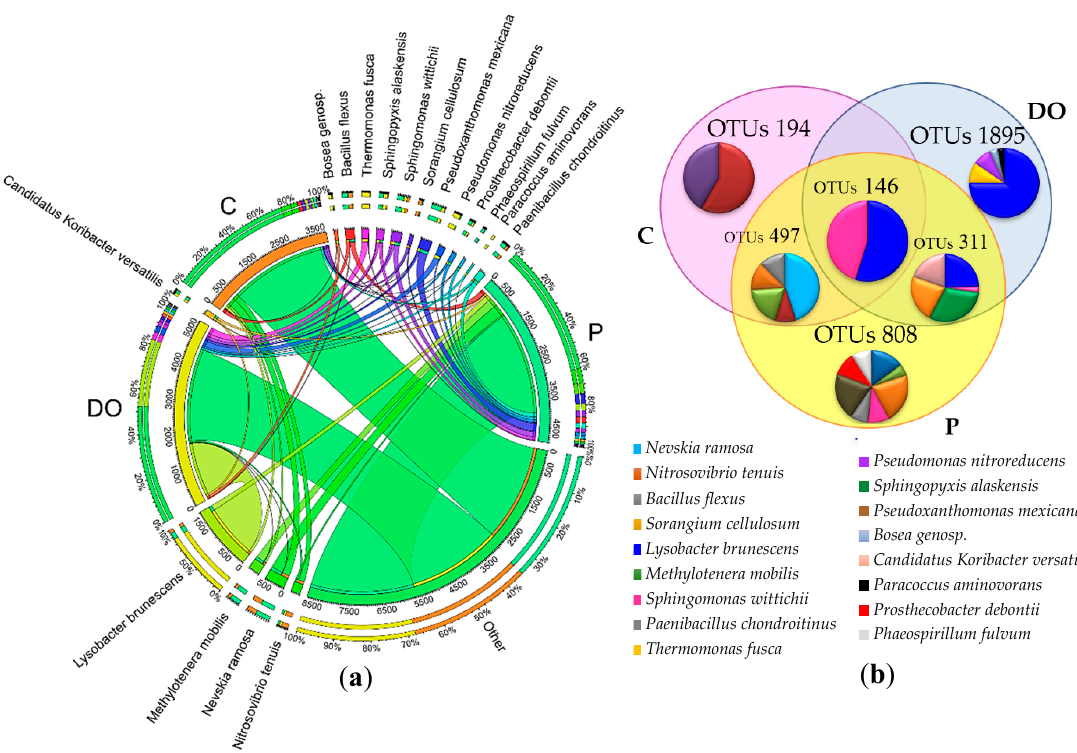
Figure 6. Abundance of bacterial communities at the species level ( a ) in uncontaminated soil (C), soil contaminated with diesel oil (DO) and soil contaminated with unleaded petroleum (P). Abundances